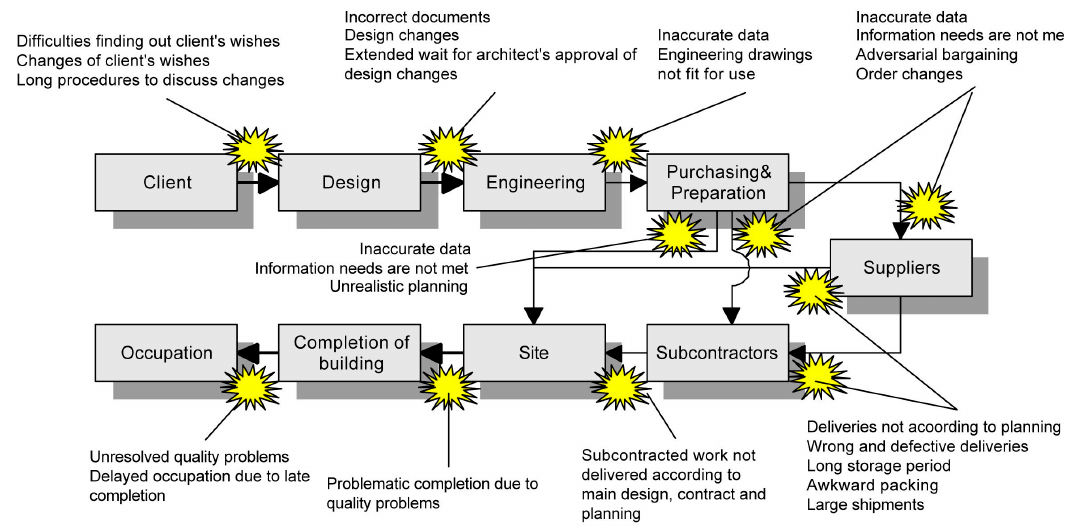
Figure 3. General problems in the process of construction [22].